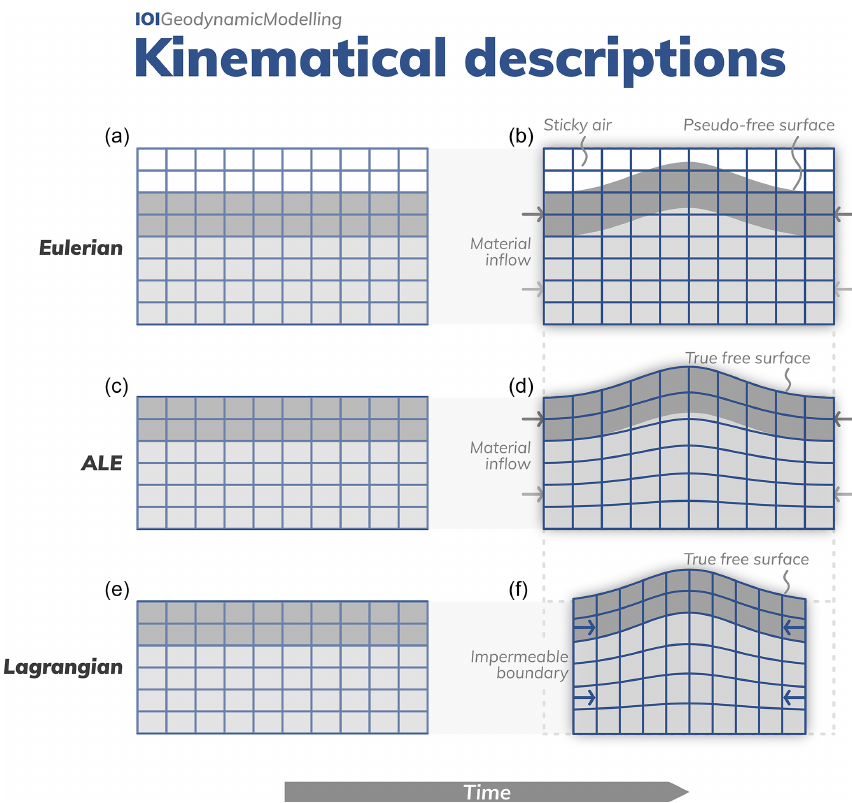
Figure 5. Kinematical descriptions for a compressed upper-mantle model setup. (a, c, e) The undeformed, initial model setups and (b, d, f) the deformed model after a certain amount of model time has passed. In the Eulerian kinematical description (a, b) the computational mesh is fixed and the generated positive topography is accommodated by implementing a layer of sticky air above the crust. When an arbitrary Lagrangian–Eulerian approach is used, (c, d) the domain width is often kept constant in geodynamic applications such that the mesh only deforms vertically to accommodate the topography. In the Lagrangian formulation, (e, f) the mesh deforms with the velocity computed on its